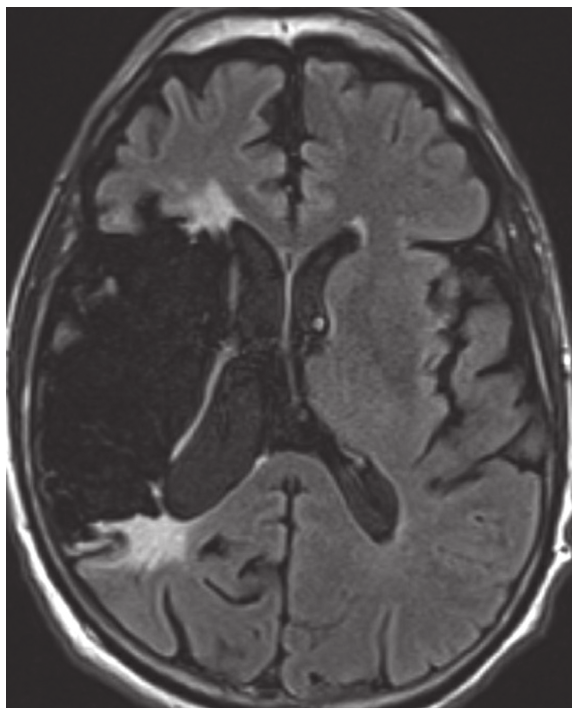
Figure 1: Magnetic resonance imaging (MRI). Fluid-attenuated inversion recovery (FLAIR) sequence shows the encephalomalacia from the right middle cerebral artery (MCA)